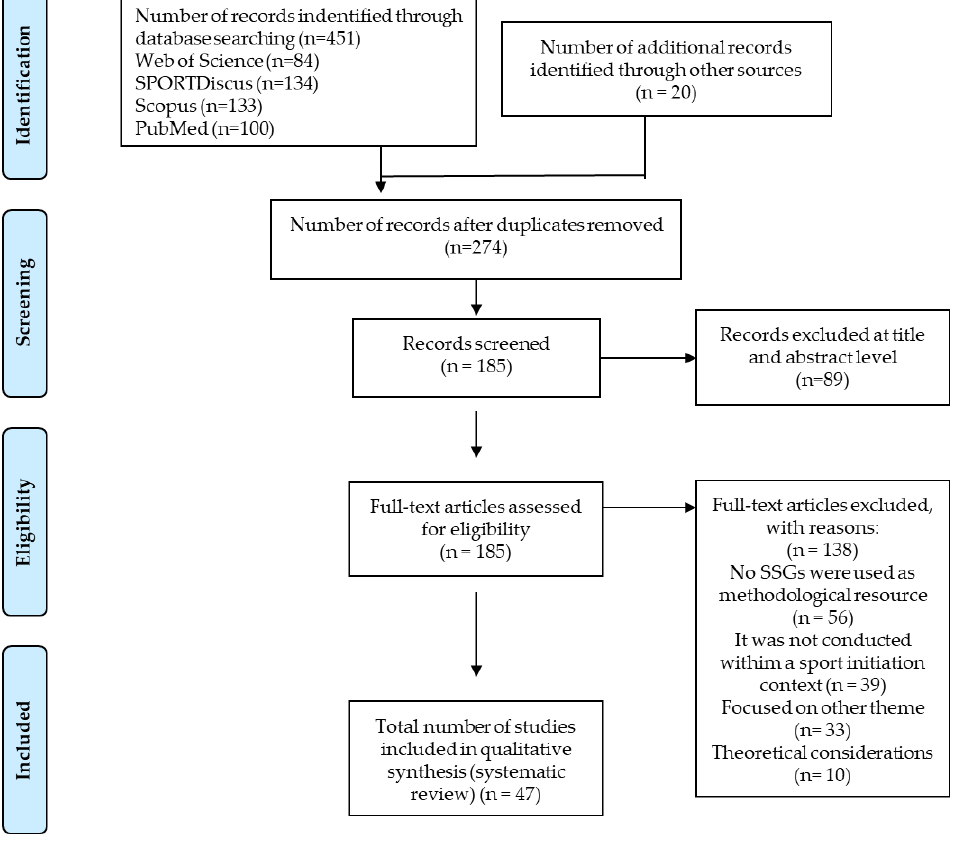
Figure 1. Flow chart.